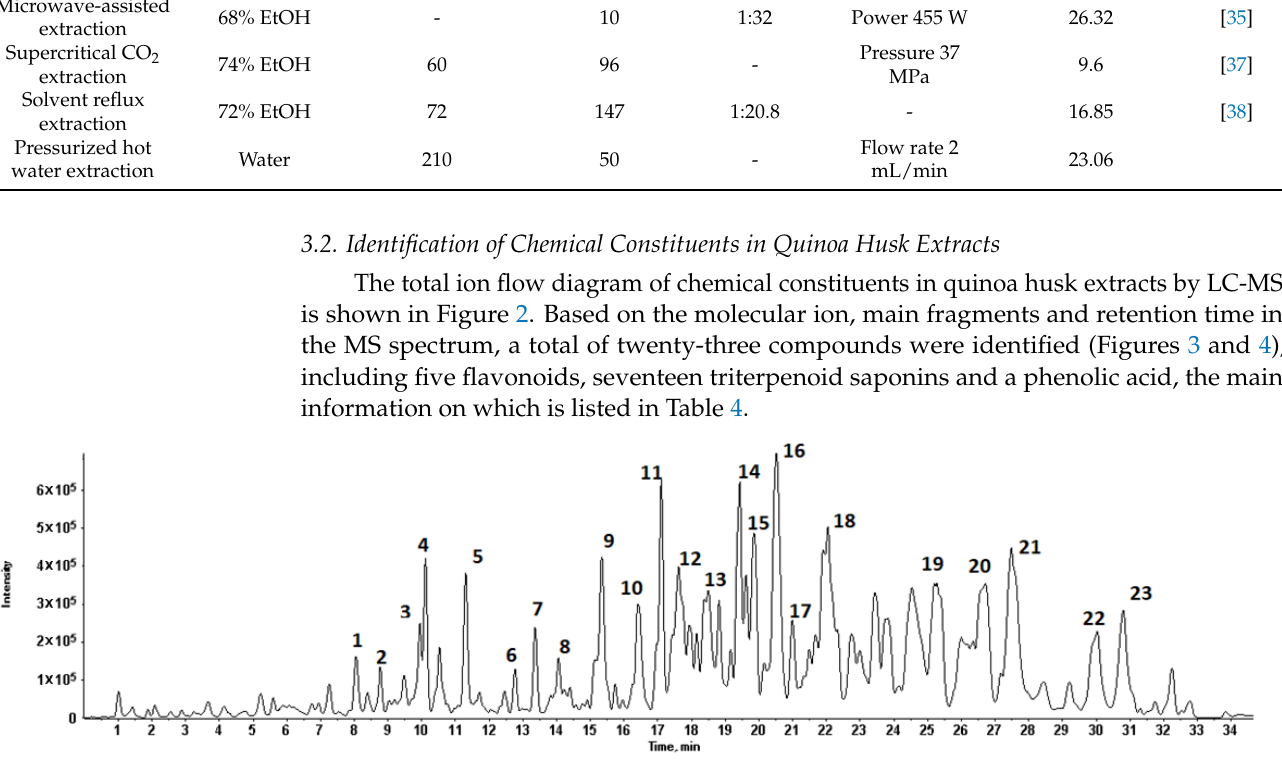
Table 3. Comparison of total saponins extraction technology in quinoa husks.